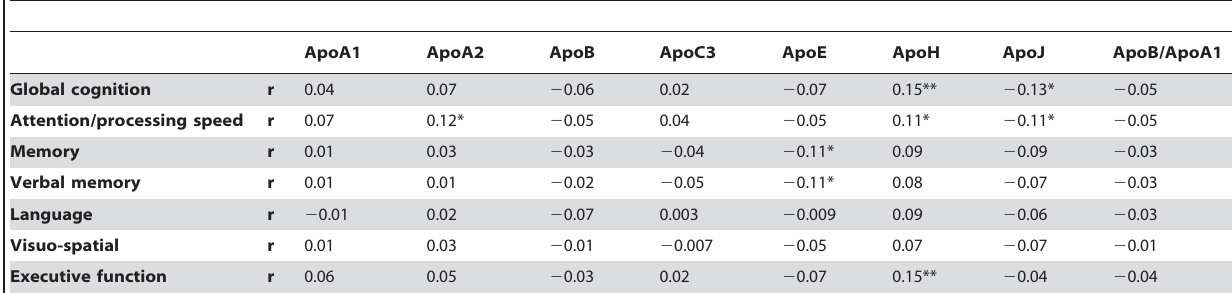
Table 4. Partial correlations between apolipoprotein levels and global cognition/cognitive domain composite scores at Wave